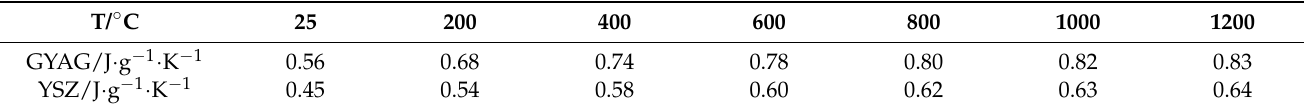
Table 4. Specific heat capacity value ( C p ) of GYAG and YSZ.